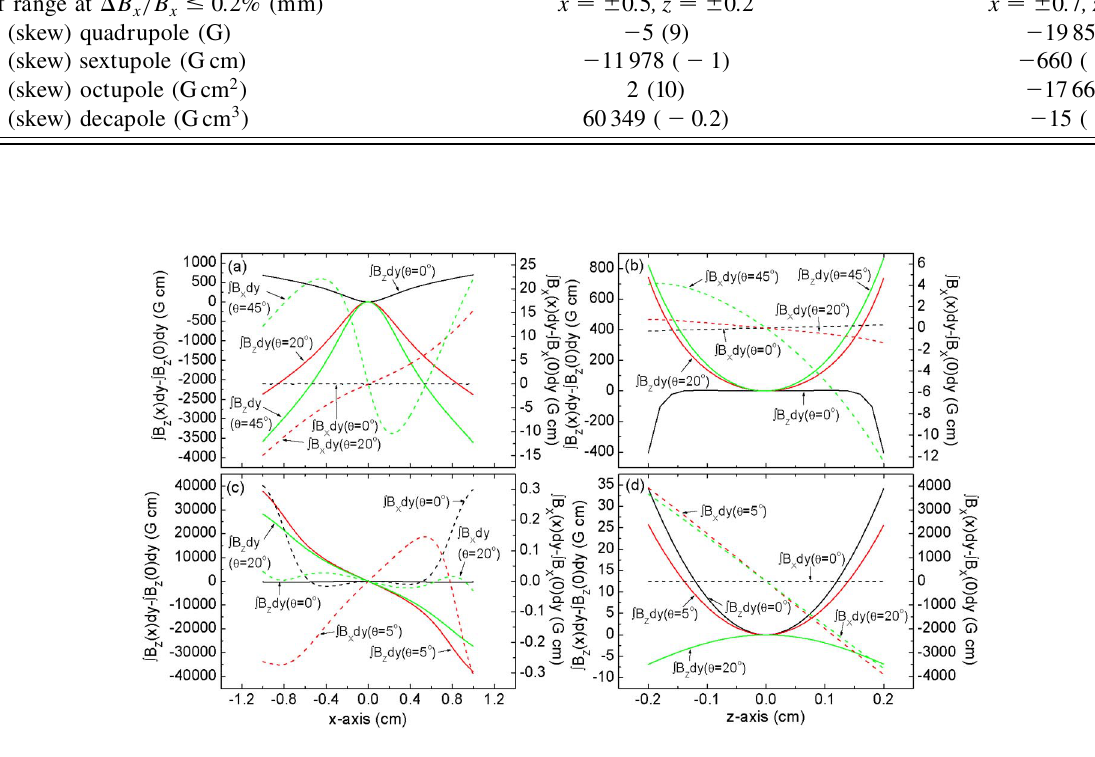
FIG. 7. (Color) Distribution of calculated integral field strength along the transverse axis: the region of the effective field that (cid:3) x; z (cid:4) dy and R B (cid:3) x; z (cid:4) dy in (a) and (b) the racetrack coil undulator and in (c) and (d) the staggered includes R B x z